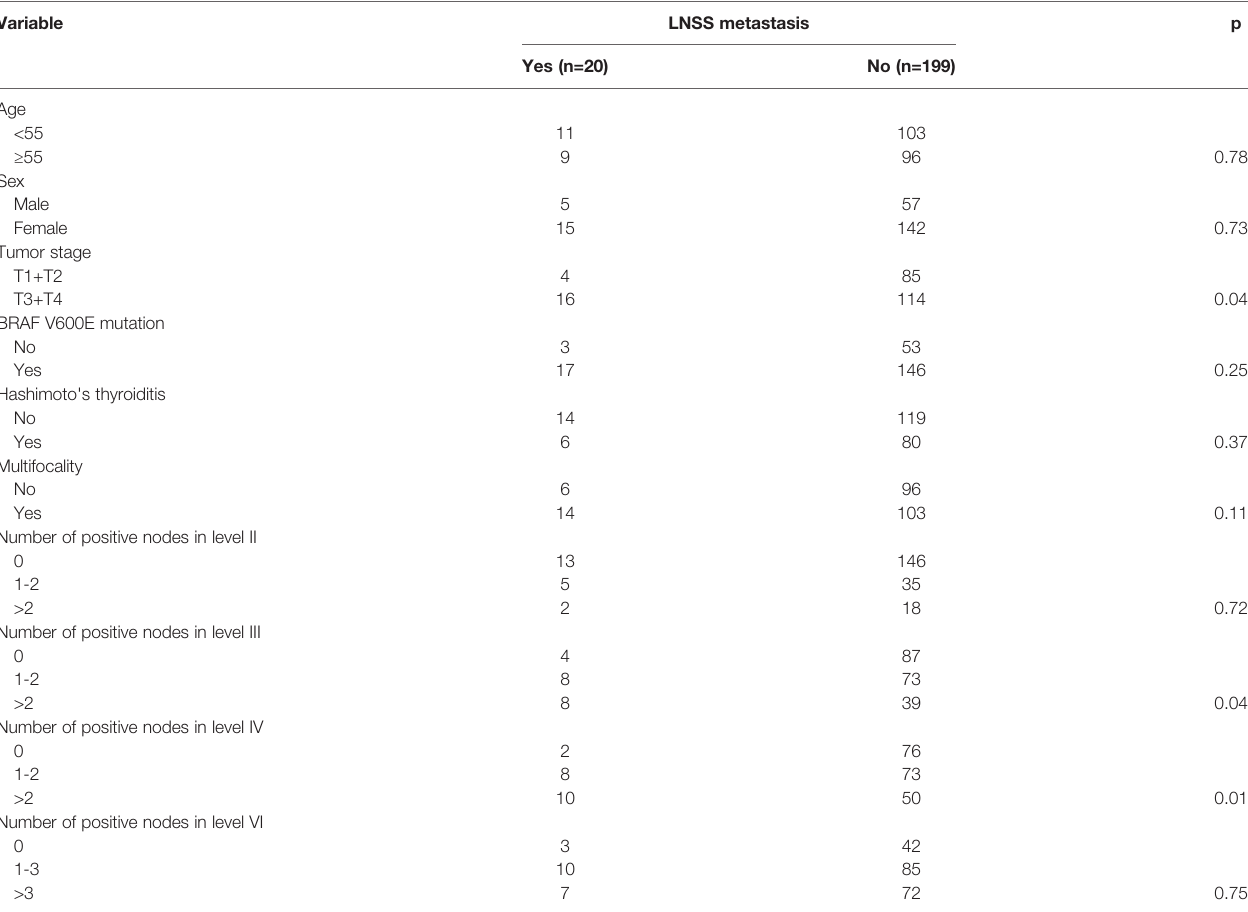
TABLE 1 | Relationship between lymph node between sternocleidomastoid and sternohyoid muscle (LNSS) metastasis and clinicopathologic features.